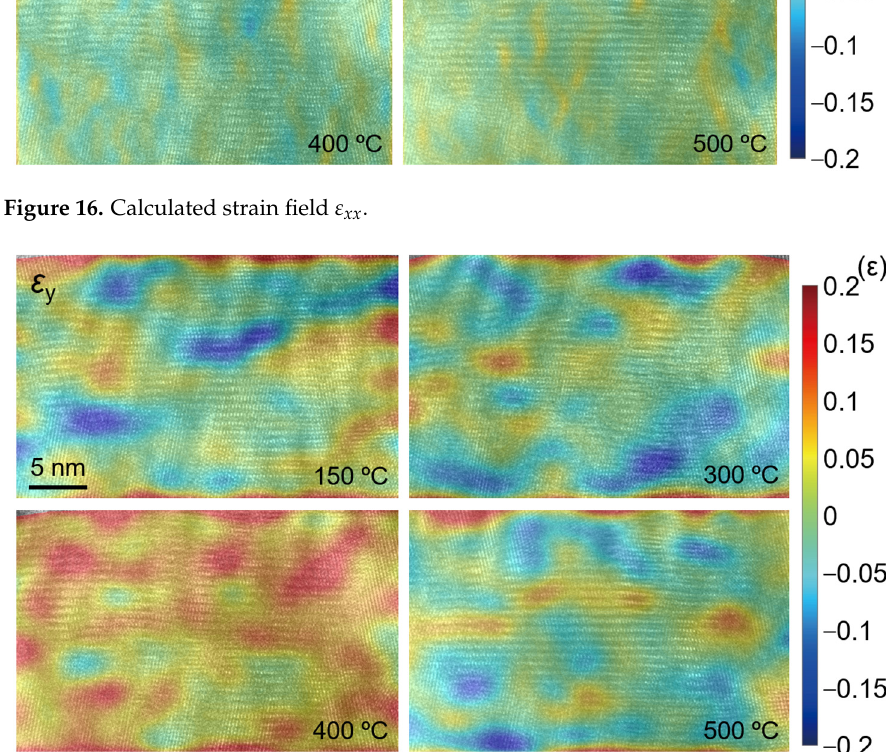
Figure 17. Calculated strain field ε yy .